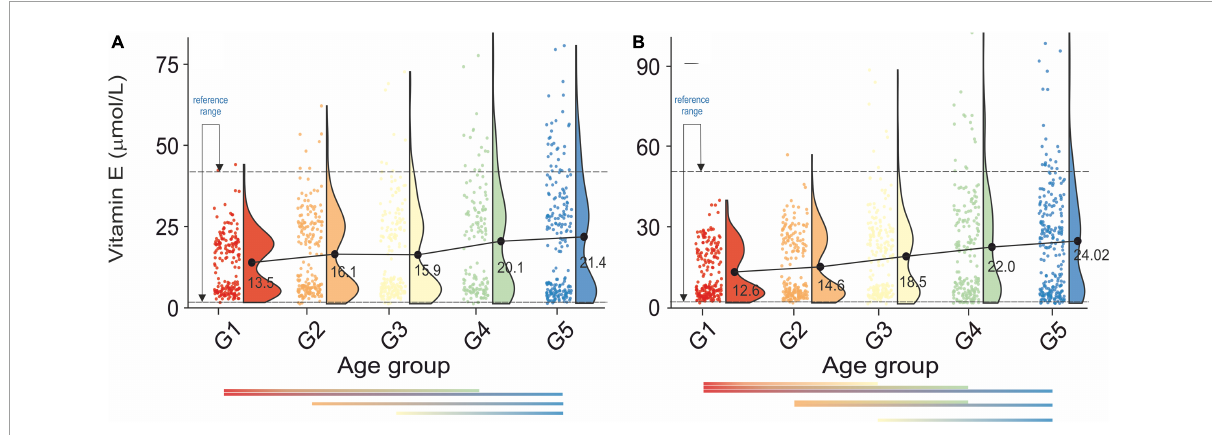
FIGURE4 Rain-cloud plots of age-dependent changes in vitamin E levels as a function of age group G1: 20 ≤ 1 < 30, G2: 30 ≤ 2 < 40, G3: 40 ≤ 3 < 50, G4: 50 ≤ 4 < 60, and 60 ≤ G5 < 70 years of age-stratified by gender (A) men, (B) women. Mean values for a specific sample are truncated to one decimal place. Color bars refer to statistically significant differences between groups at P < 0.05.